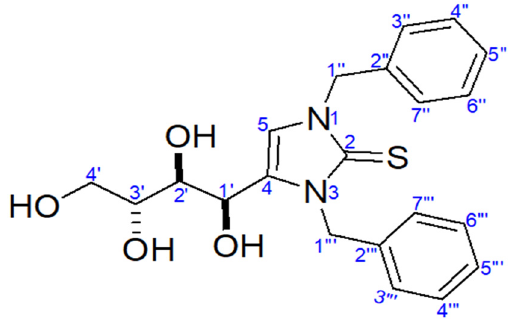
Figure 1: The chemical structure of persicaline, which was isolated from S. persica